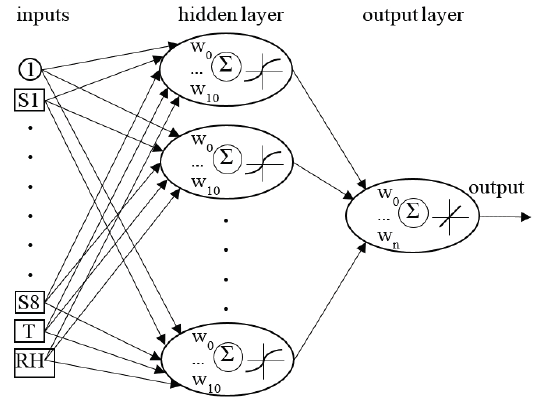
Figure 2. Architecture of neural network designed to predict wastewater quality.